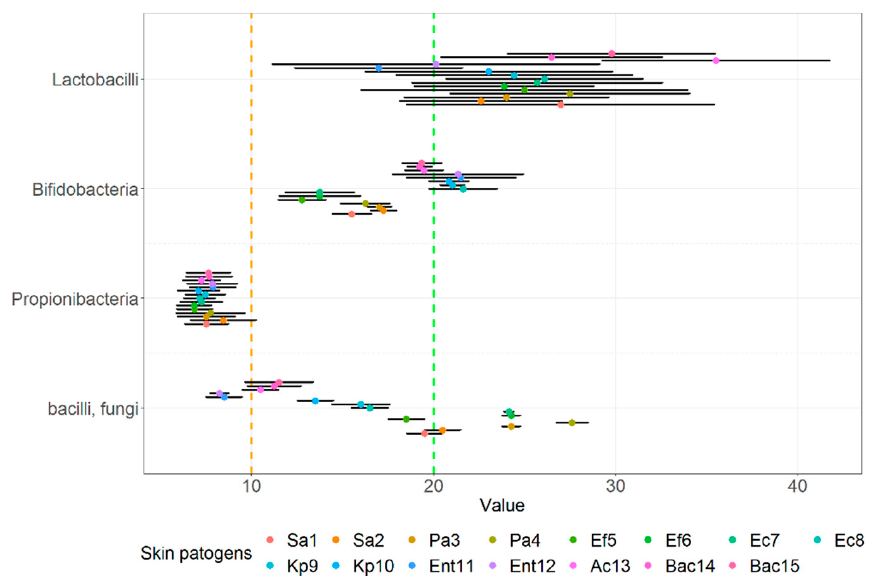
Figure 4. Means of inhibition zones together with 95% CI of probiotics and other beneficial microbes, divided into groups according to main species, against clinical skin pathogens using the agar spot assay.